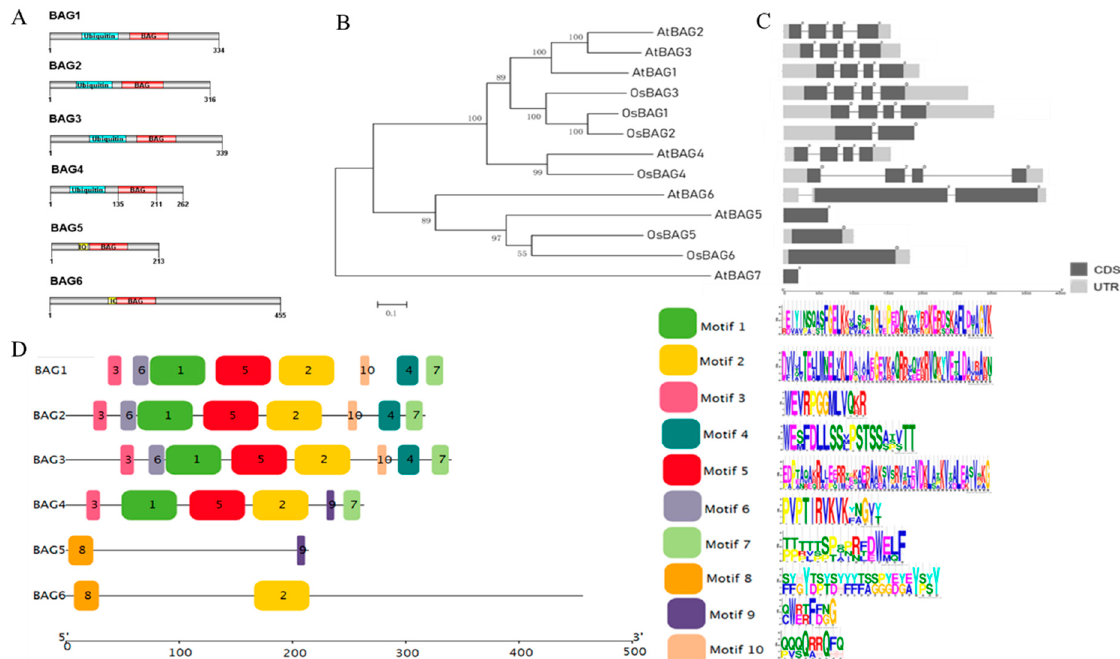
Figure 1. Structural and phylogenetic analyses of OsBAGs. ( A ) Domain structures of the OsBAG proteins. The positions of the BAG domain (BD; red), ubiquitin-like domain (blue), and calmodulin-binding motif (yellow) are shown. ( B ) Phylogenetic relationships of 13 OsBAG / AtBAG proteins. The phylogenetic tree was constructed with MEGA 6.0 software using the neighbor-joining (NJ) method with 1000 bootstrap replicates. ( C ) Gene structures (exon–intron organization) analysis of OsBAG / AtBAG . The gene structures were drawn online with Gene Structure Display Server 2.0. The CDSs, introns, and UTRs are marked with black boxes, gray lines, and gray boxes, respectively. The scale bar is shown at the bottom. ( D ) Analysis of the conserved domains of the OsBAG proteins. Differently colored boxes represent different conserved motifs of OsBAG proteins.